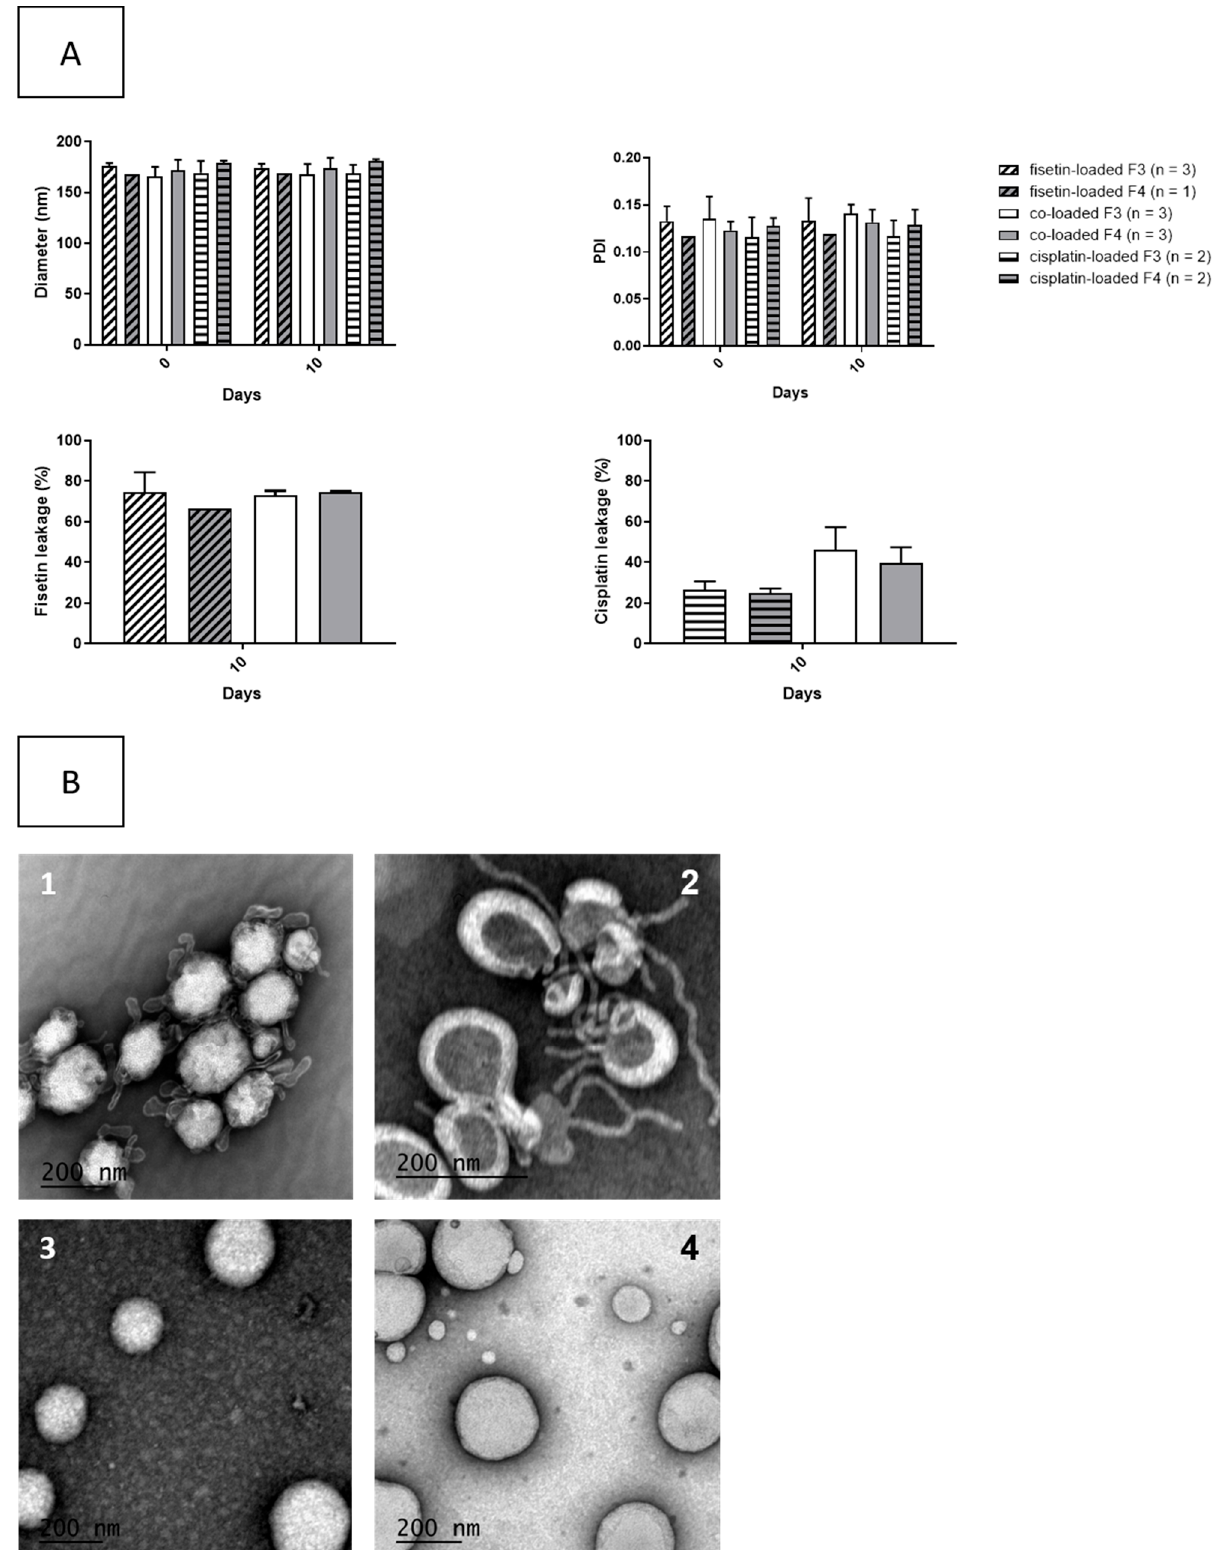
Figure 1. Stability of the liposomal formulations. ( A ) stability of size, PDI and drug leakage of the different liposomal formulations over 10 days (mean ± SD). ( B ) TEM of the liposomal formulations co-encapsulating cisplatin and fisetin (1: formulation 3 and 2: formulation 4) and liposomal formulation encapsulating only fisetin (3) or only cisplatin (4) after three days of storage.